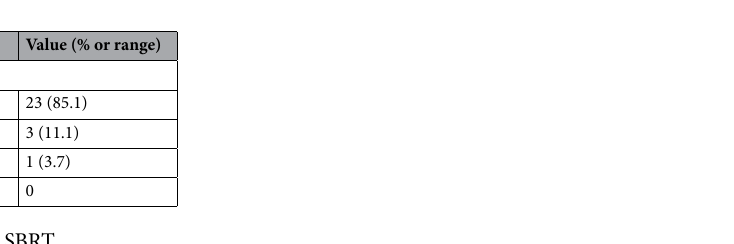
Table 4. Toxicity after 2nd